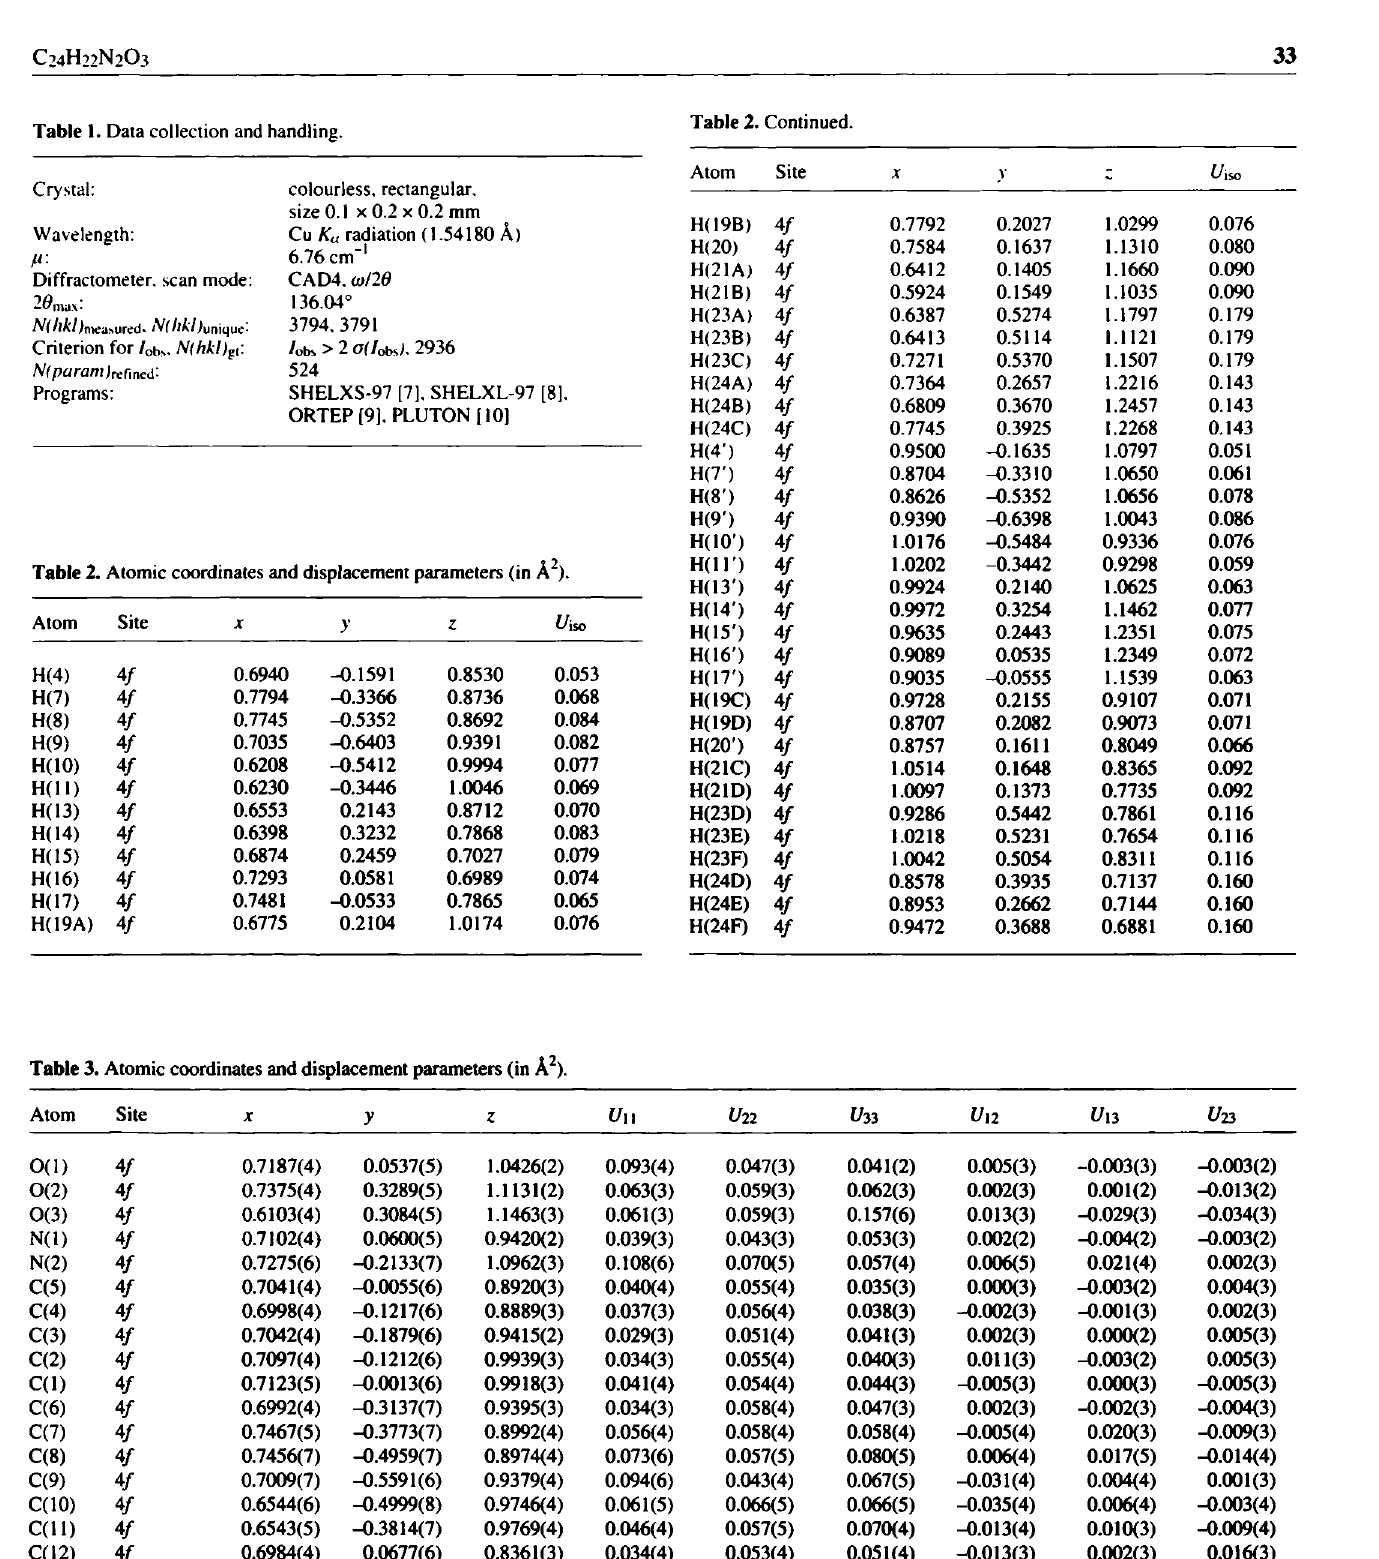
Table 3. Atomic coordinates and displacement parameters (in À 2